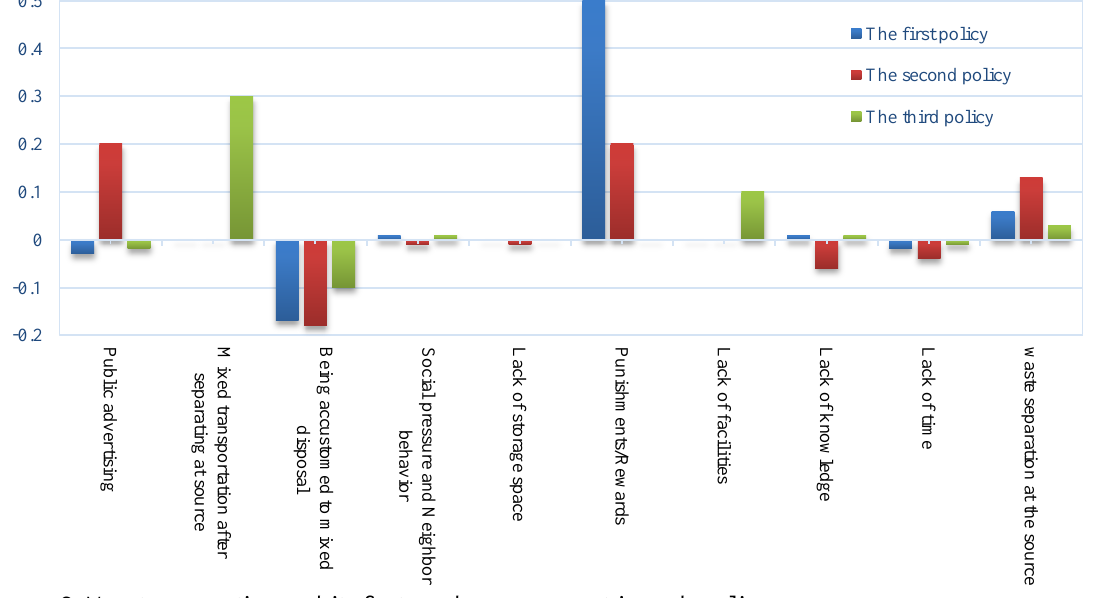
Figure 6. Waste separation and its factors change percent in each